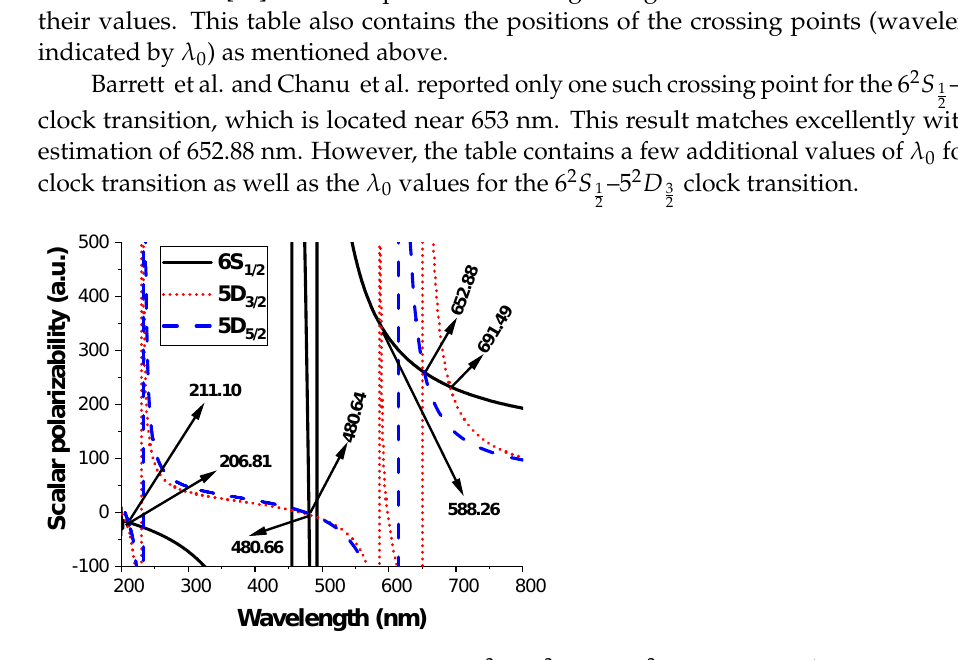
, 5 2 D 3 and 5 2 D 5 states of Ba + . Here, the different 2 2 2